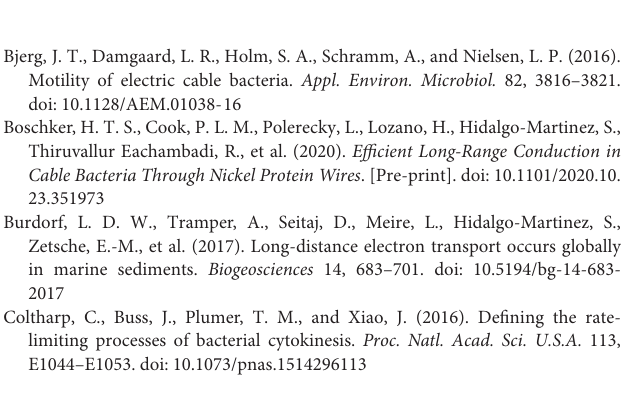
Supplementary Figure 1 | NanoSIMS images of the 15 N atom fraction measured along the length of a filament in the process of division. The corresponding SEM image and the nanoSIMS images of the 13 C atom fractions are shown in Figure 4 . Supplementary Figure 2 | NanoSIMS images of the 13 C atom fraction measured along the length of all followed filaments. Mosaic image obtained via scanning electron microscopy (SEM) showing the filaments measured, as indicated by dashed lines. Supplementary Method | Stepwise description of how to visualize the depth variation in the nanoSIMS data along a lateral profile using Look@NanoSIMS. Supplementary Datasheet 1 | Raw data showing 13 C and 15 N atom fractions in individual cells from the filaments analyzed in this